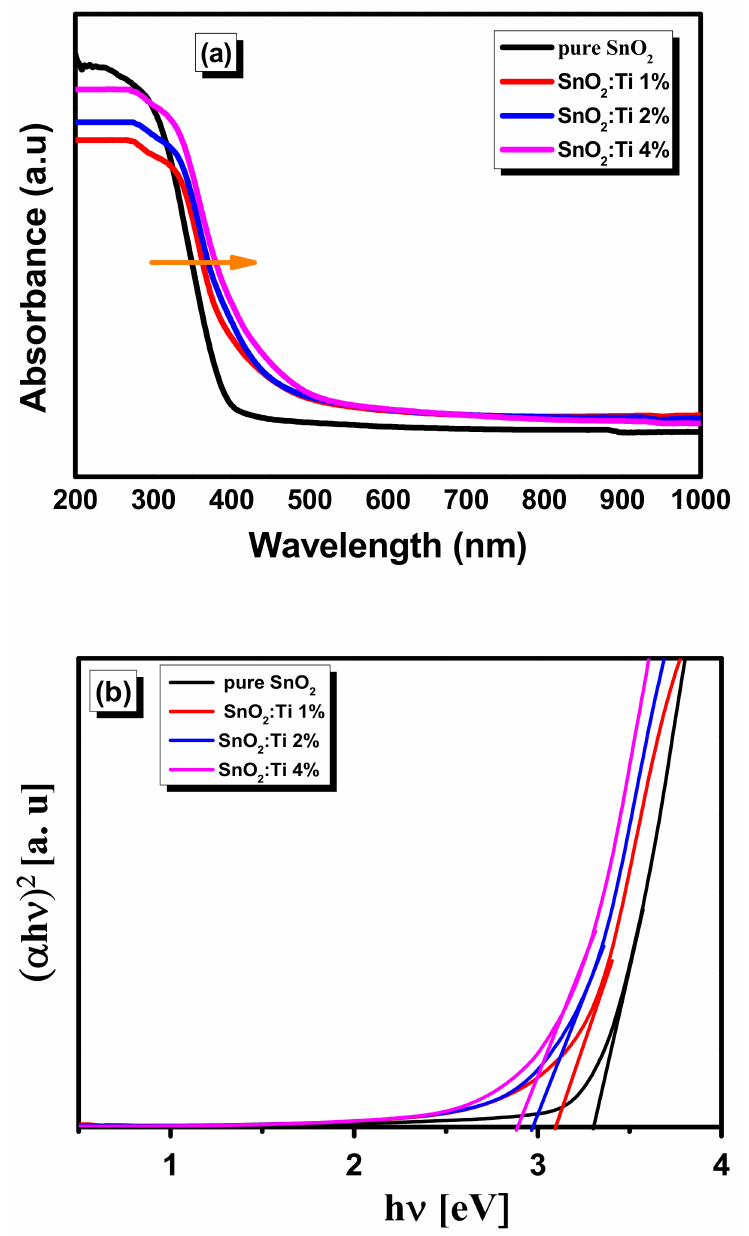
Figure 8. UV-vis spectra of Ti–SnO 2 NPs ( a ). Plots of ( α h ν ) 2 versus h ν of Ti–SnO 2 NPs ( b ). The band gap energies of Ti–SnO 2 NPs were determined using Tauc-Lorentz approach through the expression (Equation (3))